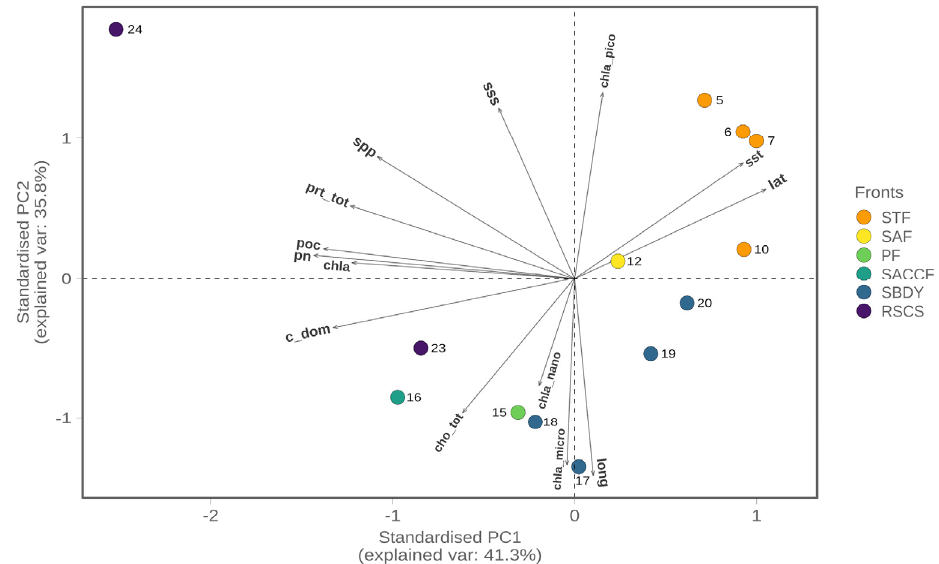
Figure 7. Principal Component Analysis biplot with each individual sample colored by front. STF—